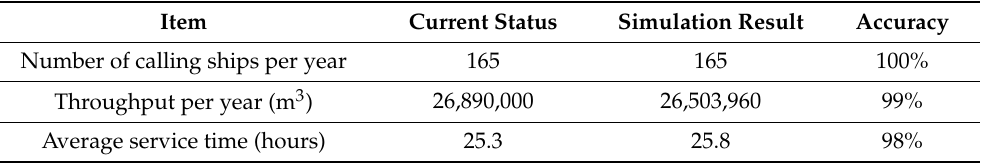
Table 8. The accuracy of simulation